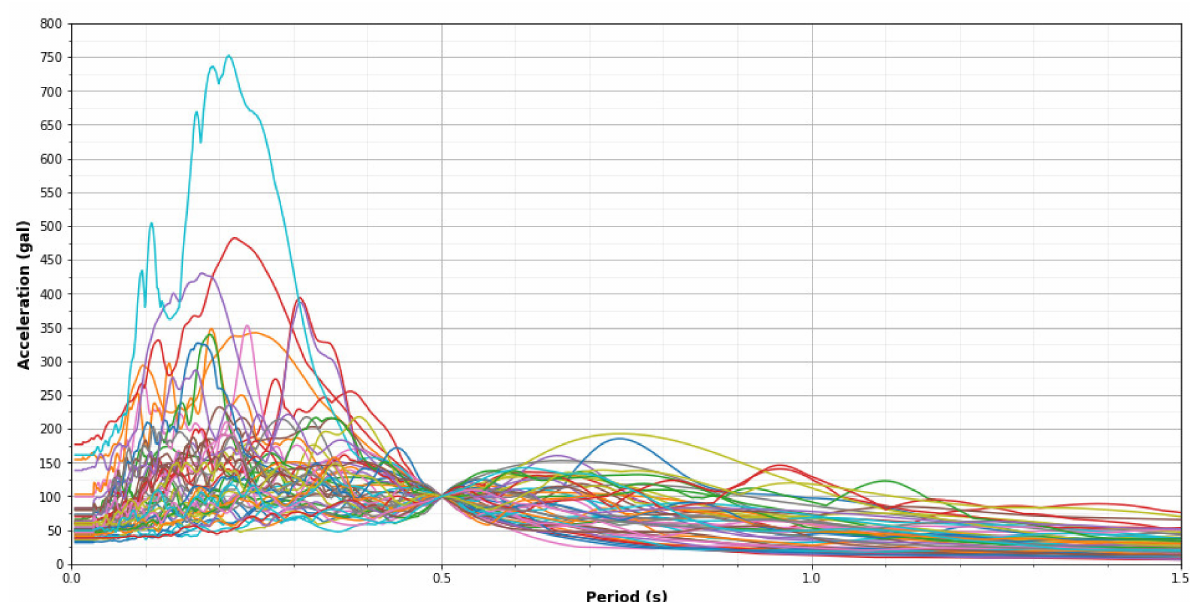
Figure 17. Acceleration response spectrum of 50 records scaled to have the same values at the fundamental period T 1 = 0.5